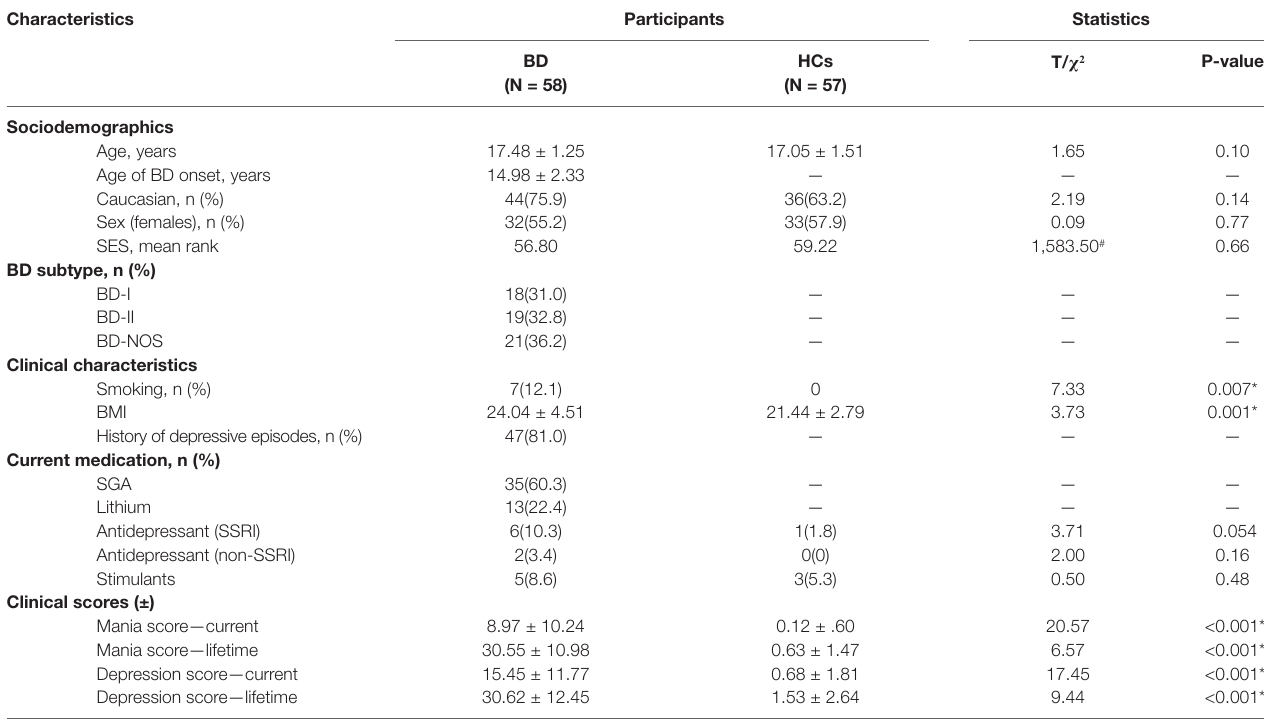
TABLE 1 | Demographic and clinical characteristics. a